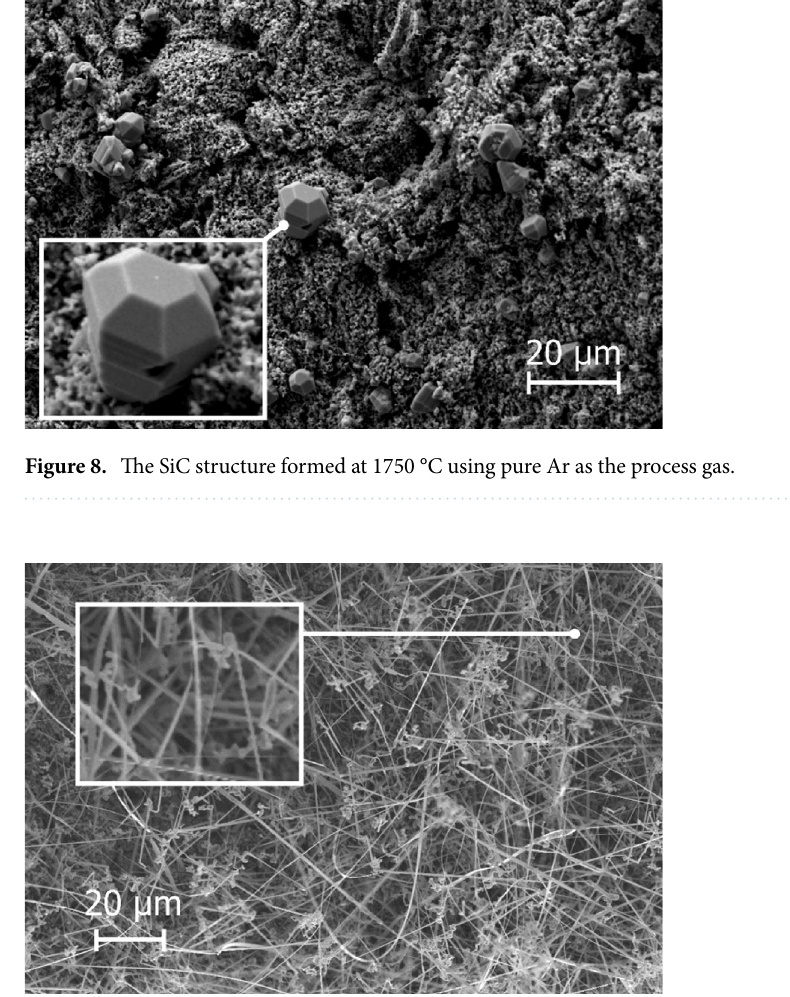
Figure 9. The SiC structure formed at 1650 °C using pure H 2 as the process